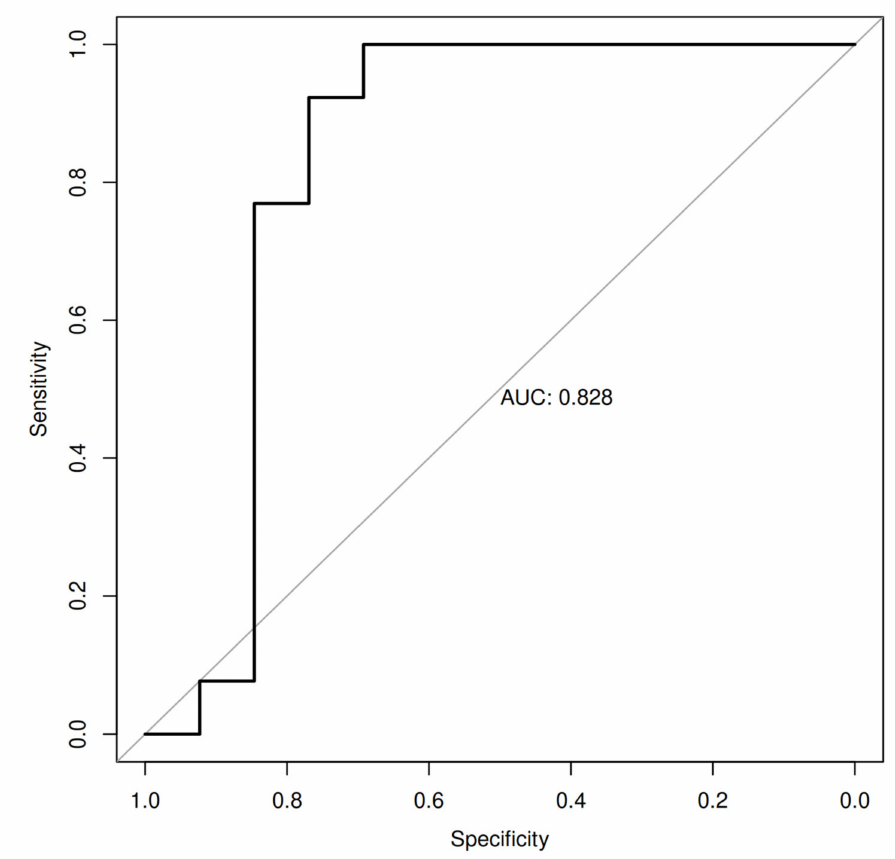
Figure 3. ROC (receiver operating characteristic) curves with the area under the ROC curve (AUC) for the RF-ML algorithm with Lactococcus, Lactobacillales, Erysipelotrichales, Streptococcus, Lipo1, BMI, Lachnospiraceae and muscle mass identified as the important predictors for discriminating between WLPB-pre and WLPB-post groups. Abbreviations: FPR, false positive rate; RFM-L, Random Forest machine learning; TPR, true positive